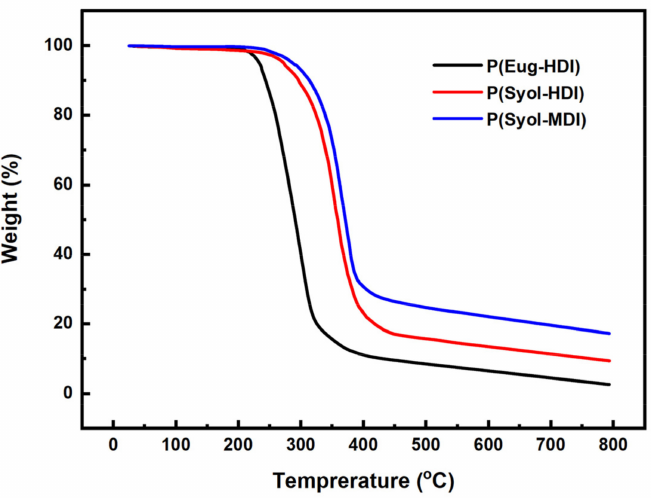
Figure 6. Thermogravimetric curve of different monomer polymerization